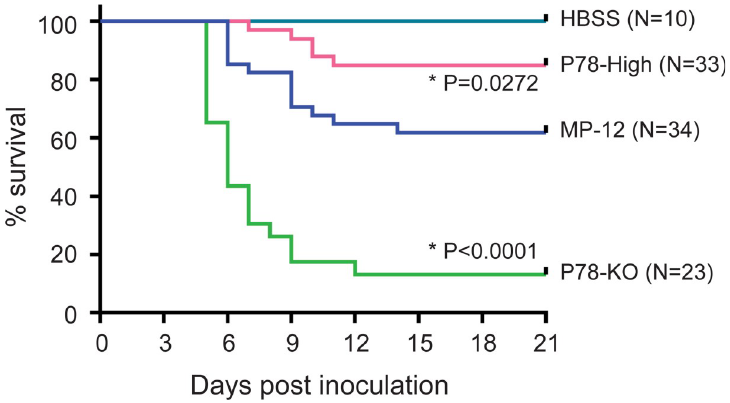
Fig 6. Virulence of MP-12 mutants in young mice. Sixteen-day-old CD-1 mice were inoculated with HBSS or 10 4 PFU of the indicated viruses intraperitoneally and observed for 21 days after inoculation. Differences in survival curves between MP-12 and its variants were analyzed by log-rank